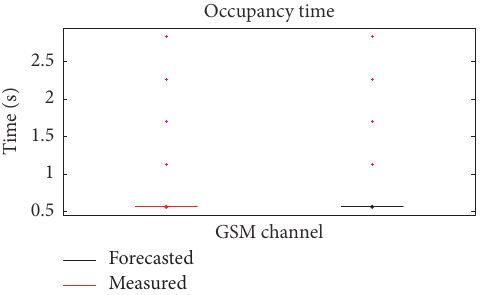
Figure 10: Application of the proposed